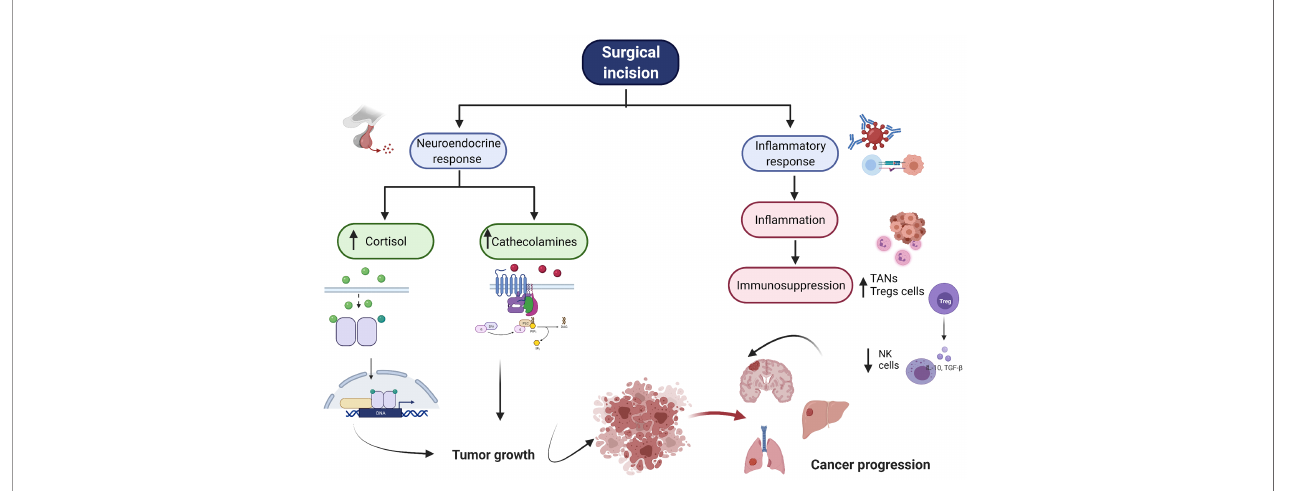
FIGURE 2 | Overview of Surgical Stress Response. The fi gure represents the neuroendorine and the in fl ammatory response associated with surgery. After surgical incision, there is an increase of cortisol and cathecholamines. Additionally, there is a profound in fl ammatory response folllowed by immunosupression. All these together enables cancer cells to growth, proliferate and produce distant metastasis. NK, natural killer cell, TAN, tumor associated neutrophiles, Tregs, regulartoy T